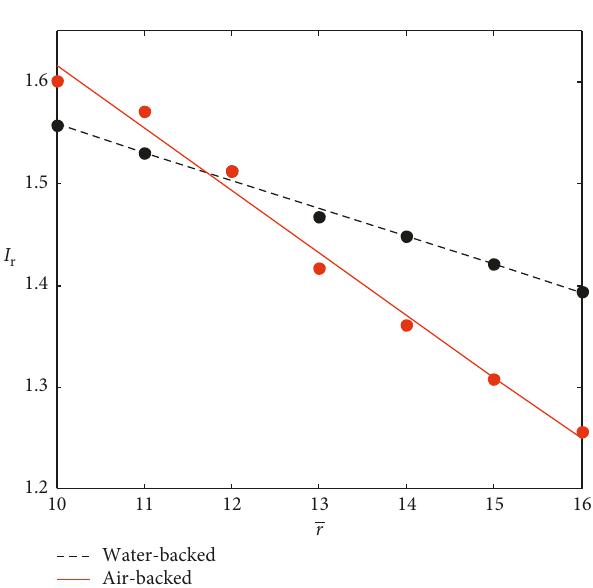
Figure 15: The reflection coefficients of impulse for different detonation